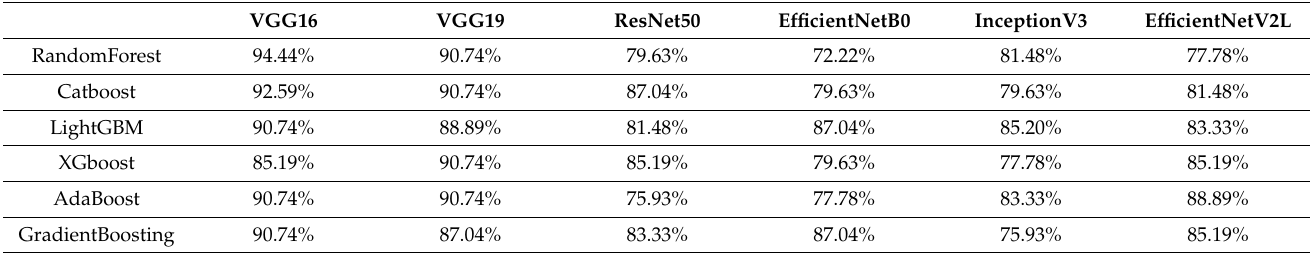
Table A6. Accuracy of each model combination for gray triangles.